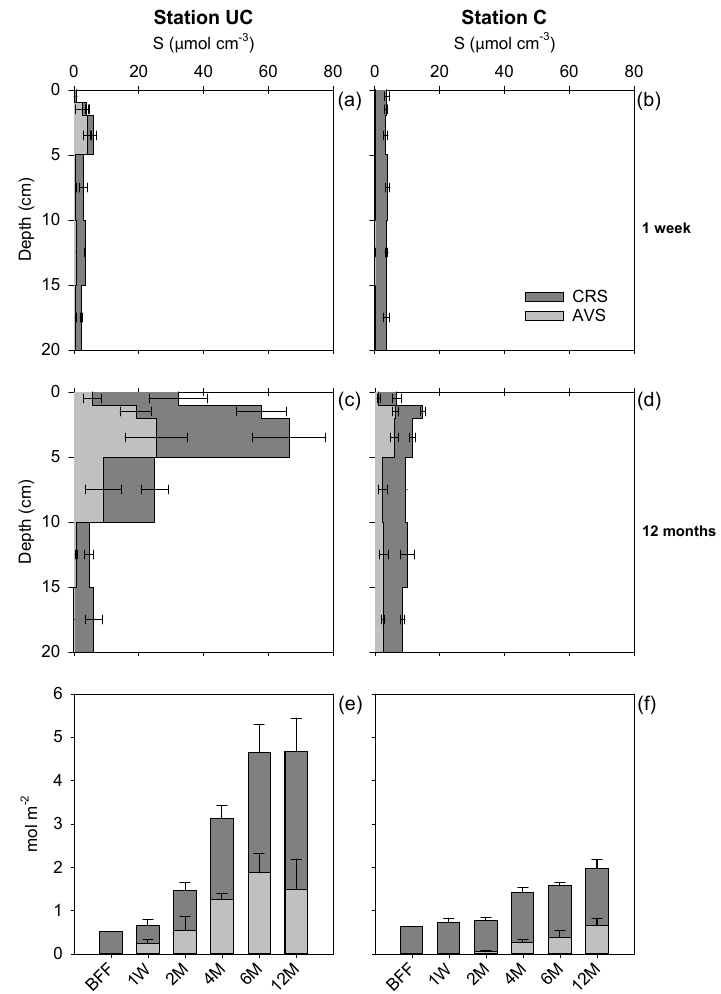
Figure 7. Upper panels (a, b) show concentration of chromium reducible sulfides (CRS) and acid volatile sulfides (AVS) in uncultivated (UC) and cultivated (C) soils before flooding (BFF) and 12 months after flooding. Lower panels (e, f) show the depth-integrated pools of AVS and CRS in the upper 20cm at various times after flooding at 1 week (1W) and 2, 4, 6 and 12 months (2M, 4M, 6M and 12M), respectively. Error bars indicate SEM ( n =